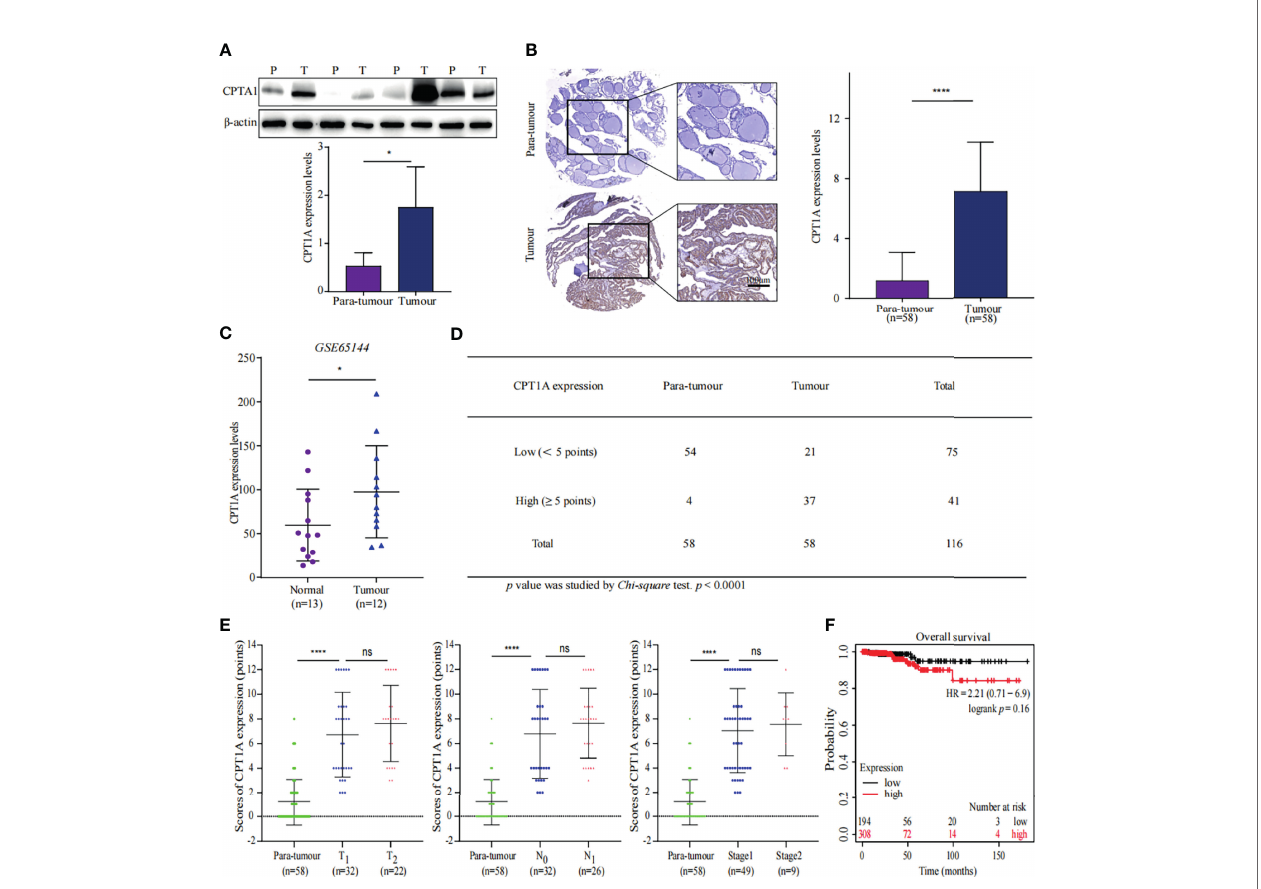
FIGURE 6 | CPT1A expression favours PTC progression. (A) CPT1A expression in tissue samples was measured using western blotting (WB). Representative WB diagrams of CPT1A are shown in the top panel. The quanti fi cation data are shown in the lower panel, * p < 0.05. Error bar indicates s.d. , two-tailed unpaired t -test. P indicates para-tumour, T indicates tumour. (B) CPT1A expression and localisation in the tissue microarray. Representative images of CPT1A (brown) immunohistochemistry in the tissue microarray are shown in the left panel. Scale bar 100µm. Statistical analysis of CPT1A protein levels in 58 paired tissue samples is shown in the right panel. **** p < 0.0001. Error bar indicates s.d. , two-tailed unpaired t -test. (C) Data of CPT1A mRNA levels were obtained from publicly available dataset (GSE65144). * p < 0.05. The error bar indicates s.d. , student t -test. (D) The number of high-CPT1A expression samples in the tissue microarray. The P value was obtained using the Chi-square test to analyse the signi fi cant difference, **** p < 0.0001. (E) Relationship between CPT1A expression and stages of thyroid cancer. Data shown in the graphs for CPT1A expression were not discrepant regarding T stage, N stage, or TNM stage of PTC, **** p < 0.0001; ns indicates: not statistically signi fi cant. All error bars indicate s.d. , two-tailed unpaired t -test. (F) High levels of CPT1A were associated with poor overall survival by analysing a pan- cancer datasets through KM plot